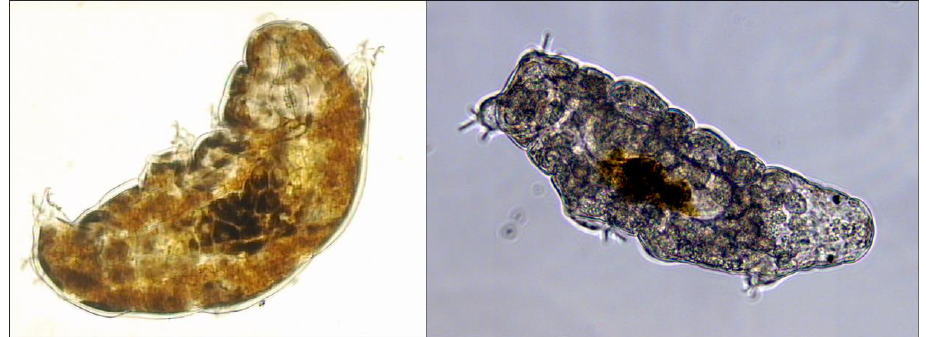
Figure 1. Light microscope images of two of the tardigrade species that have been used in studies on radiation tolerance, Richtersius cf. coronifer ( left panel ) and Hypsibius exemplaris ( right panel ).